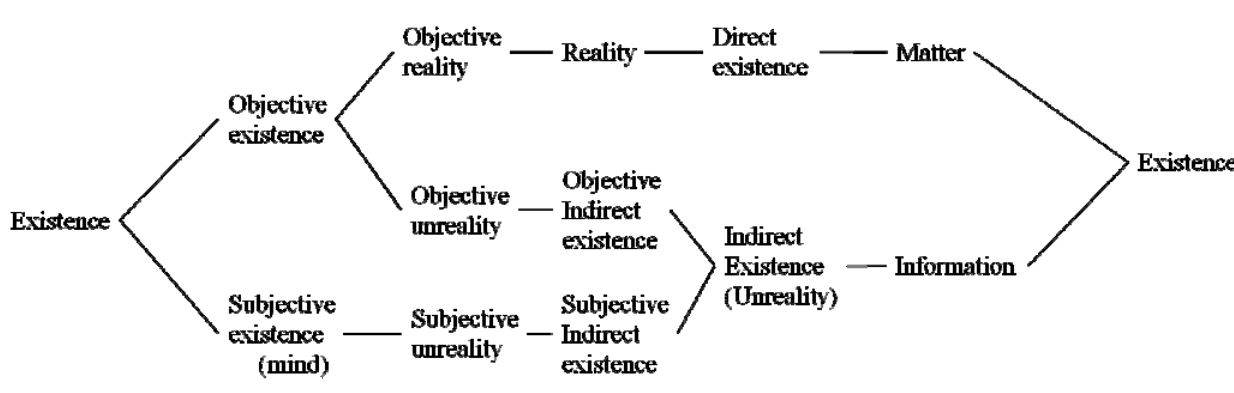
Figure 1. Diagram of the existential field